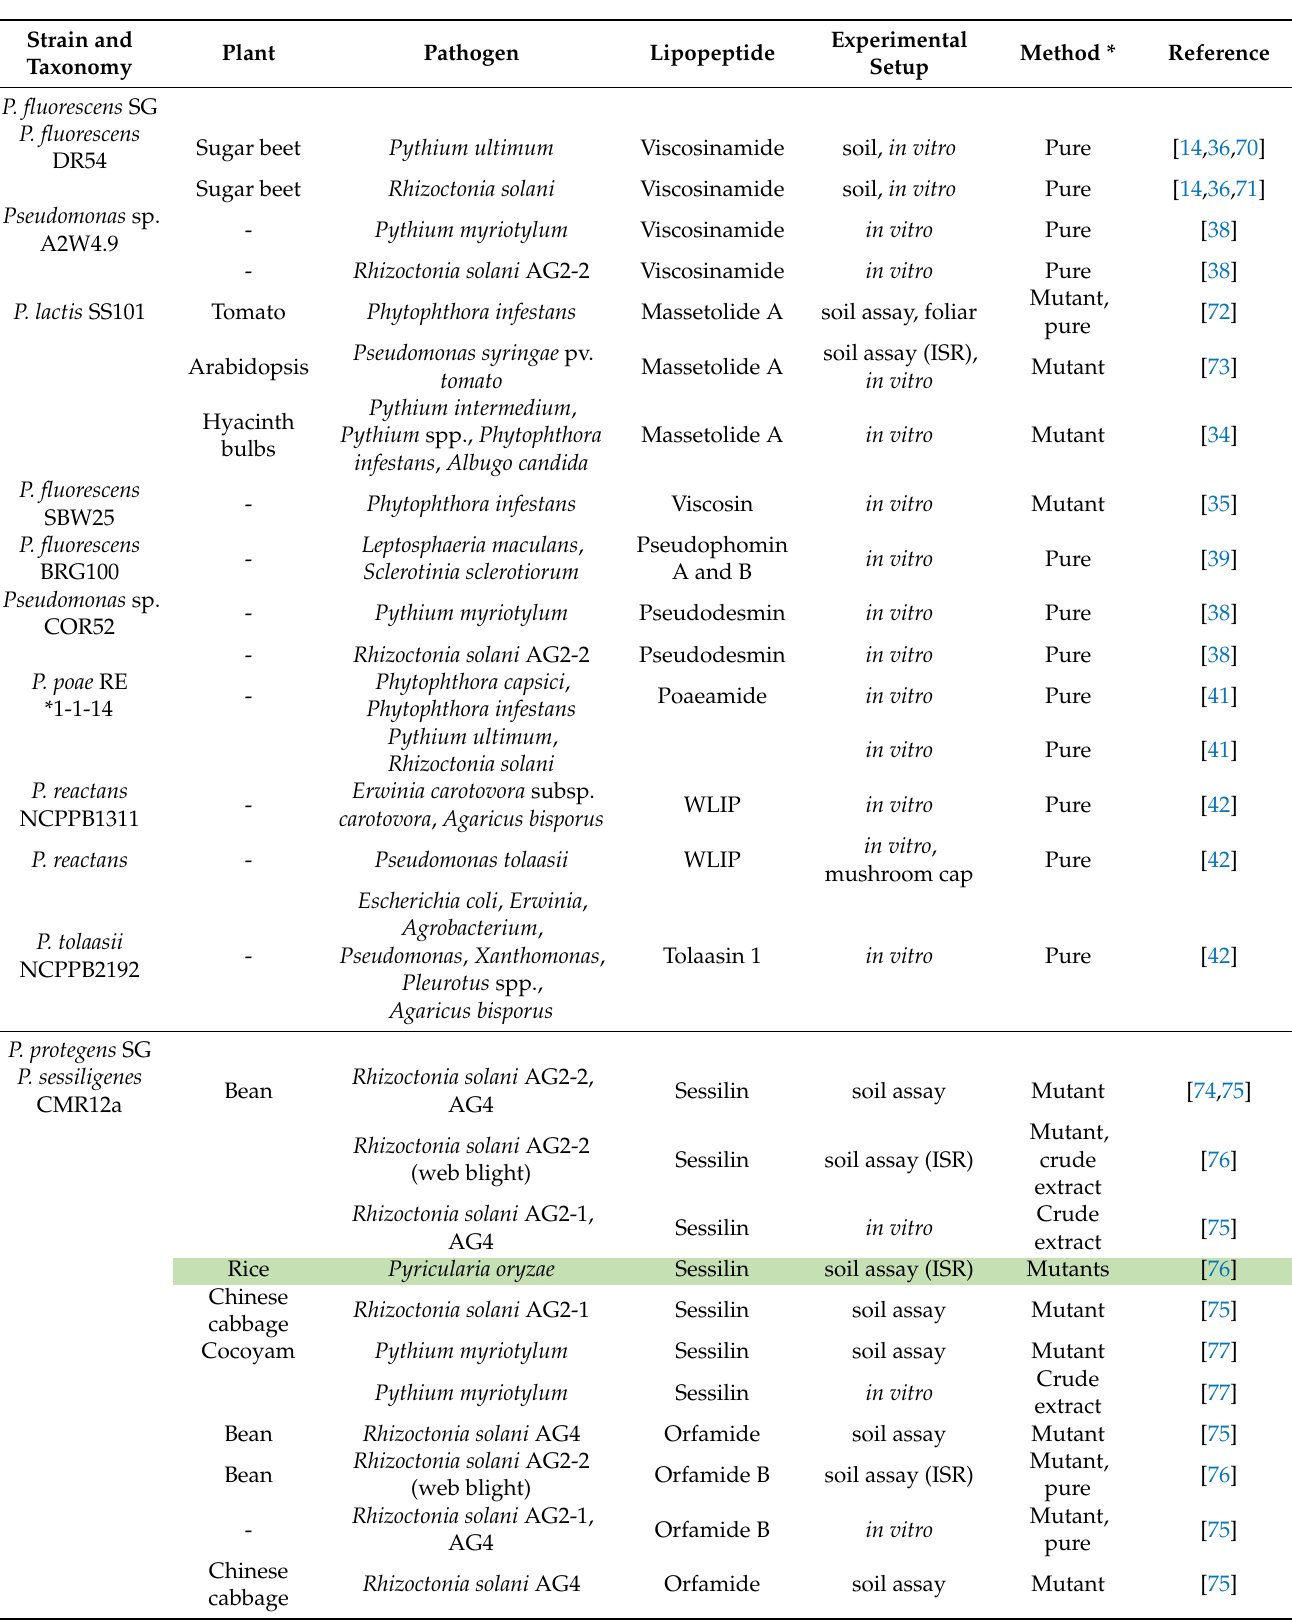
Table 2. LPs Tested Against Plant Pathogens using In Vitro, Soil and Foliar